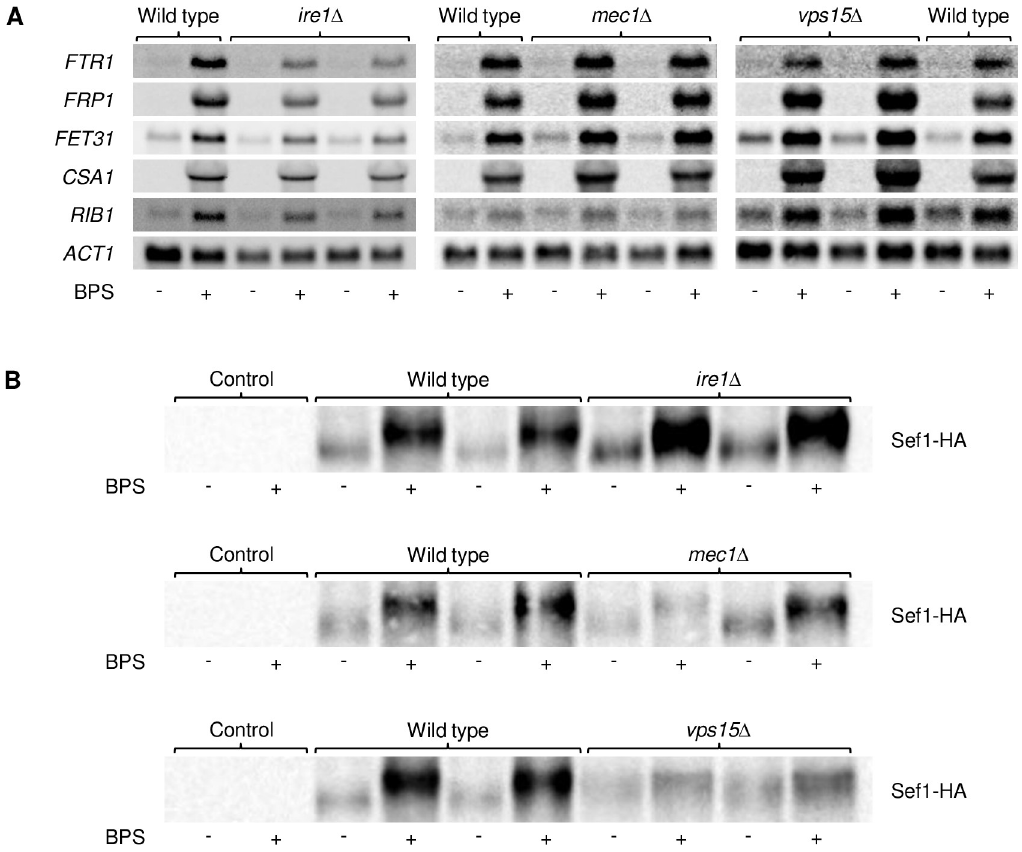
Fig 5. Upregulation of Sef1 and Sef1 target genes by iron depletion does not depend on Ire1, Mec1, and Vps15. (A) Overnight cultures of the wild-type strain SC5314 and ire1 Δ , mec1 Δ , and vps15 Δ mutants were inoculated in fresh YPD medium without or with BPS and grown for 5 h at 30˚C. Expression of the indicated iron-regulated genes was analyzed by Northern hybridization with gene-specific probes; ACT1 mRNA levels served as controls. Each set of experiments was performed separately. (B) The wild-type strain SC5314 and ire1 Δ , mec1 Δ , and vps15 Δ mutants carrying a 3xHA-tagged SEF1 allele were grown as described above and Sef1-HA was detected by Western blotting with an HA-specific antibody. The untagged wild-type strain served as negative control. Both series of mutants are shown in (A) and